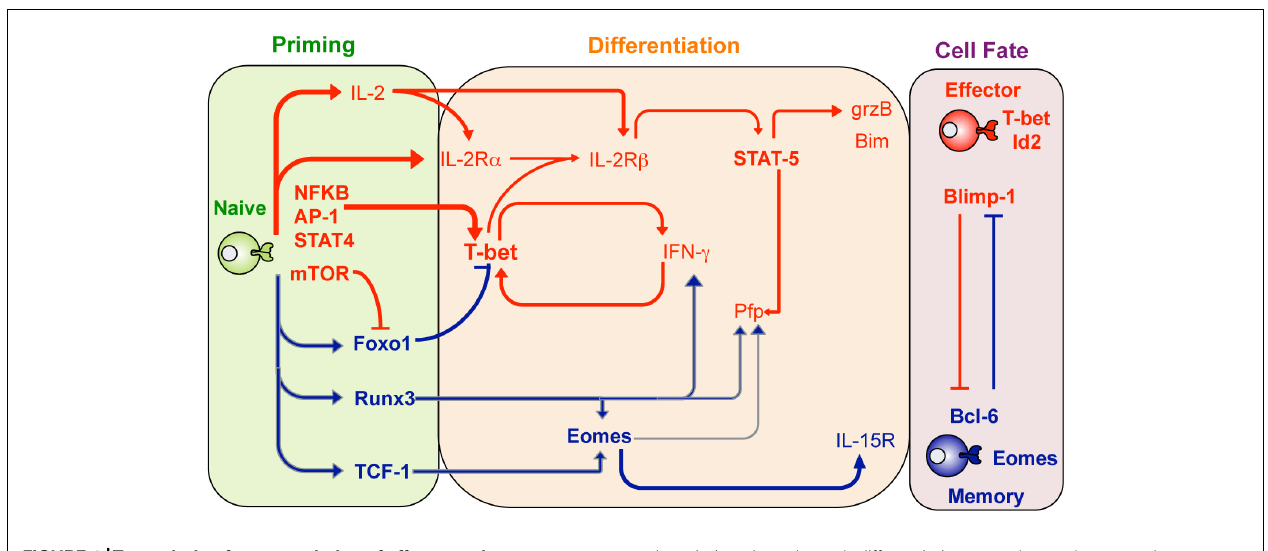
FIGURE 1 |Transcription factor regulation of effector and memory T cell differentiation. Shown are transcription factors that are expressed and act to promote either effector CTL (red lines) or memory CTL (blue lines) differentiation at the different stages after infection including